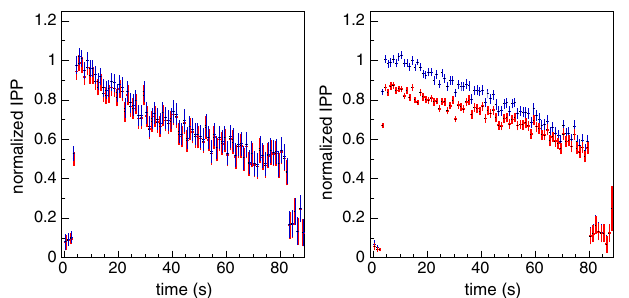
FIG. 9. Measurement of the IPP for two runs, normalized to one at t ¼ 5 s based on the typical asymmetry values described in the text. In the left panel, the detector rate is low and not much change is apparent between red (original measurement) and blue (rate corrected measurement). The right panel contains another example for a higher rate run with a considerable initial slope